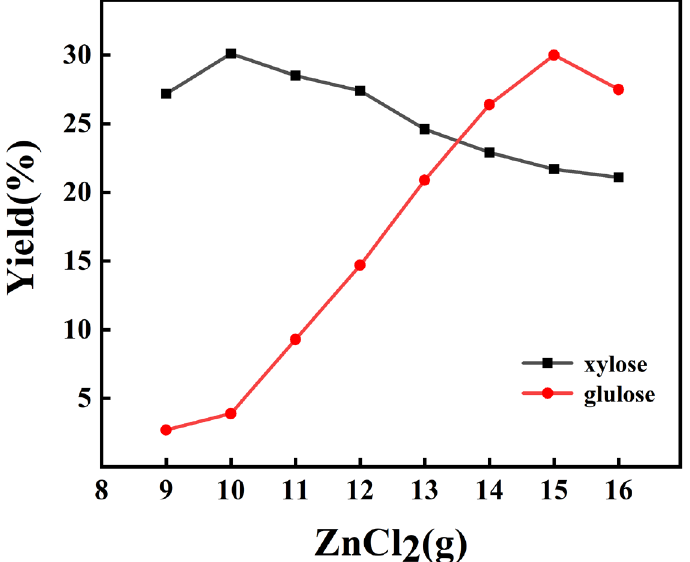
Figure 1. Effect of the concentration of ZnCl 2 on the yield of xylose and glucose (5 mL 2M HCl, ultrapure water, the total mass was 1.5 g). Table 1. Effect of ZnCl 2 content on xylose and glucose yield (one pot).